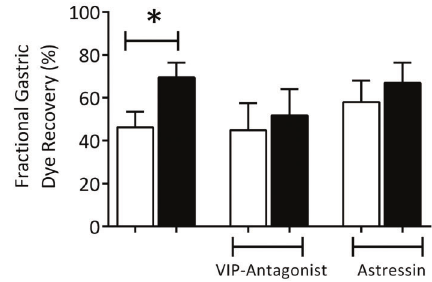
Figure 4. Neurohumoral mechanisms of acute exercise-induced gastric emptying delay. The fi gure shows the effects of pretreat- ment with the vasoactive intestinal peptide (VIP) antagonist Lys 1 , Pro 2,5 , Arg 3,4 , Tyr 6 (100 m g/kg, ip ) and astressin (100 m g/kg, ip ) on gastric retention of a liquid test meal in rats that were subjected to the sedentary (white bars) or acute exercise (5%) (black bars) protocols. The data are reported as mean ± SD. *P o 0.05 (ANOVA followed by the Tukey ’ s test).